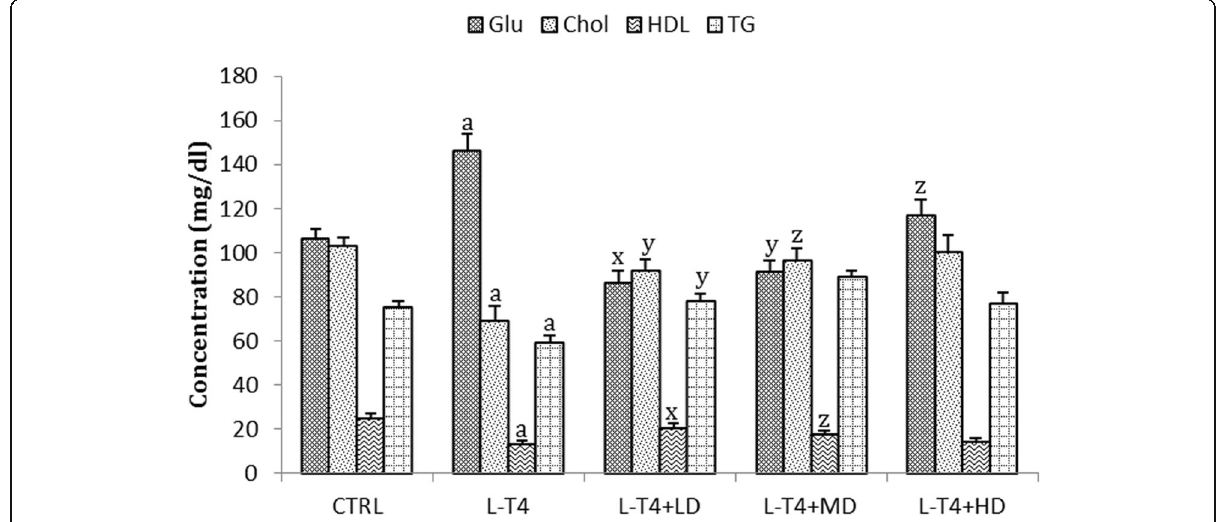
Fig. 4 Effects of ACC extract on the alterations in serum glucose and different lipids. Each bar represents the mean ± s.e.m., n=7. Ctrl, Control; L-T 4 , L- thyroxine. a P <0.001 as compared to the respective control values. x P <0.001, y P <0.01 and z P <0.5 as compared to the respective values of L-T 4 treated animals. GLU, glucose; CHOL, cholesterol; HDL, high density lipoprote in and TG,